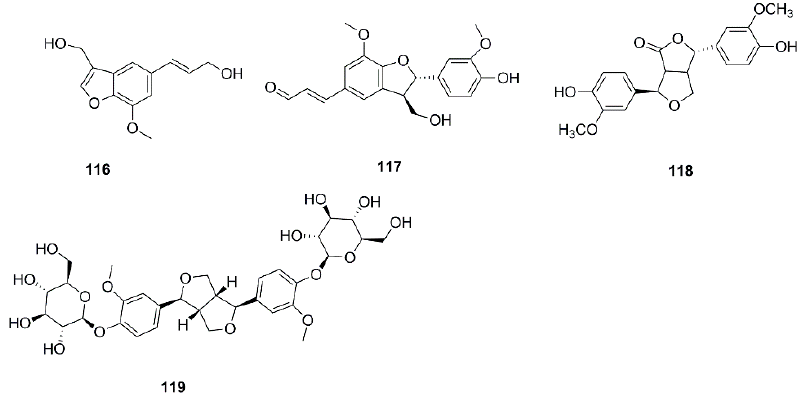
Figure 6. Chemical structures of the coumarins in X. strumarium.